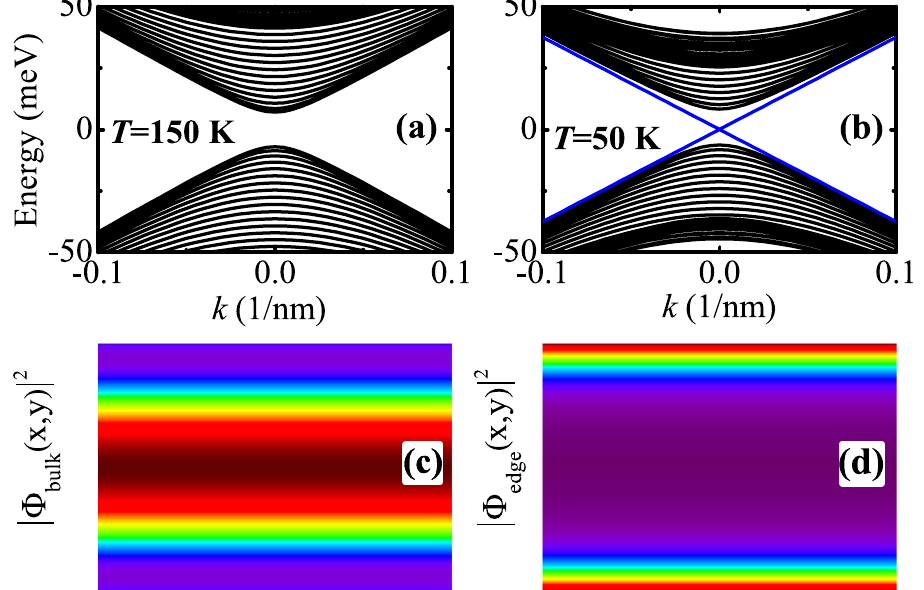
Figure 1. Demonstration of the TI phase transition driven by temperature: ( a ) and ( b ) plot the energy spectra of ribbon structures in NI and TI regimes, respectively, and ( c ) and ( d ) plot the probability density distributions for bulk and edge states at k = 0, respectively. Here, the blue solid lines and black solid curves in ( a ) and ( b ) represent the energy dispersions for edge and bulk states, respectively, and the purple and red colors in the rainbow maps in ( c ) and ( d ) represent the minimum and maximum values of probability density distribution, respectively.